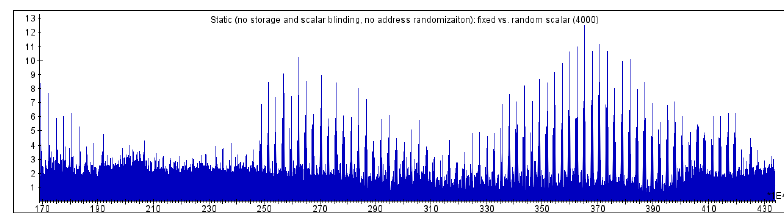
Figure 4: Static implementation TVLA (no blindings and address randomization) aligned at 1 . 65ms (1 . 7-4 . 3ms): fixed vs random